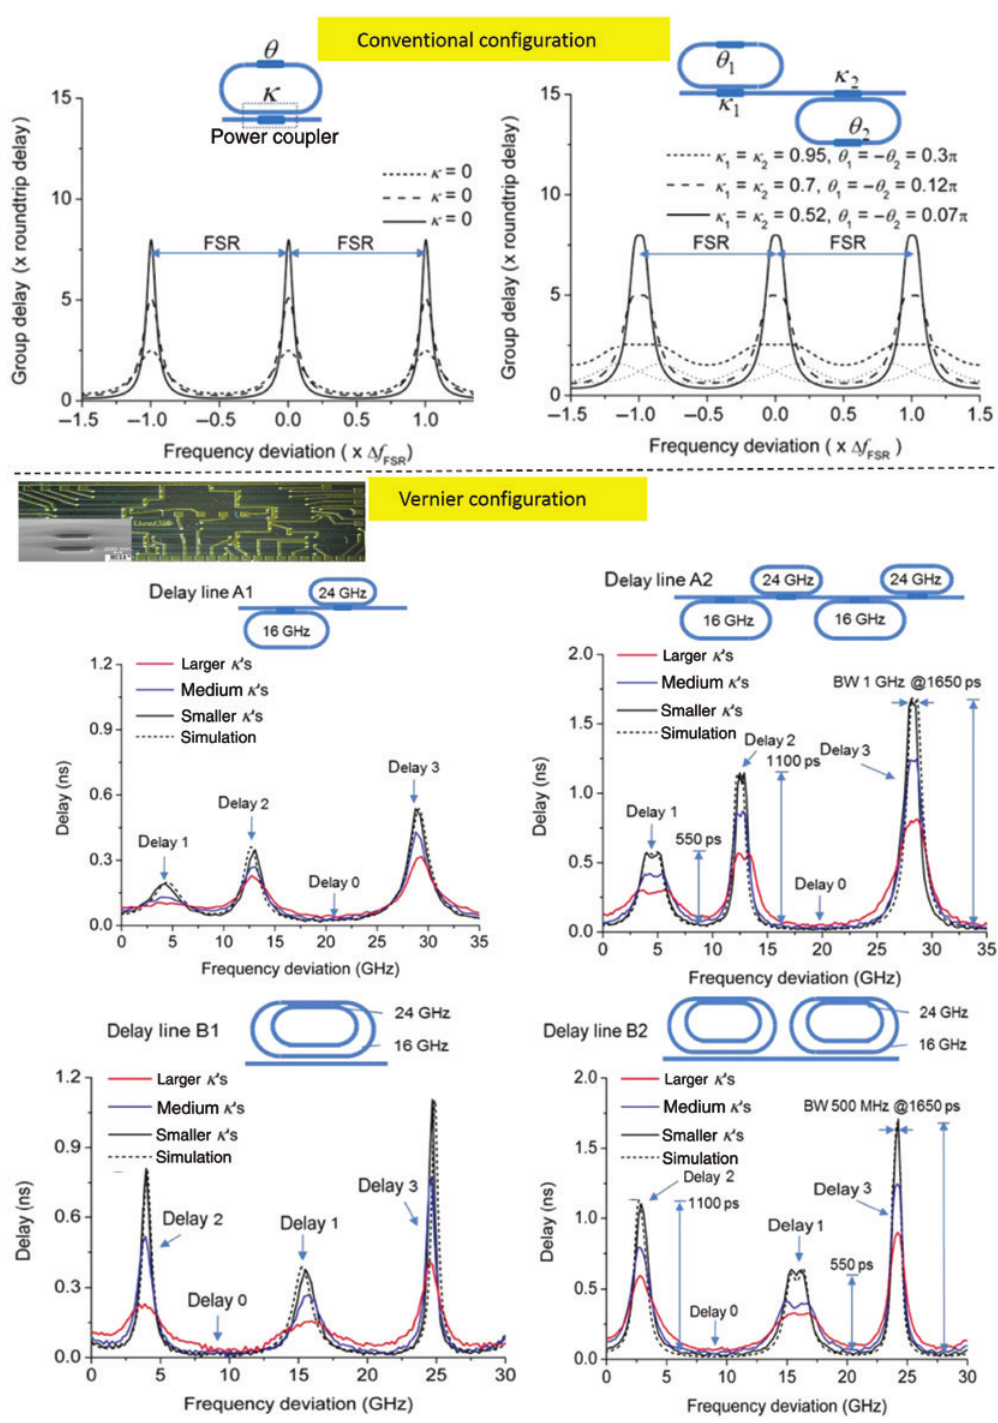
Figure 9: Tunable delay lines implemented using conventional and Vernier configurations of ring resonators [66] (Copyright in 2013,